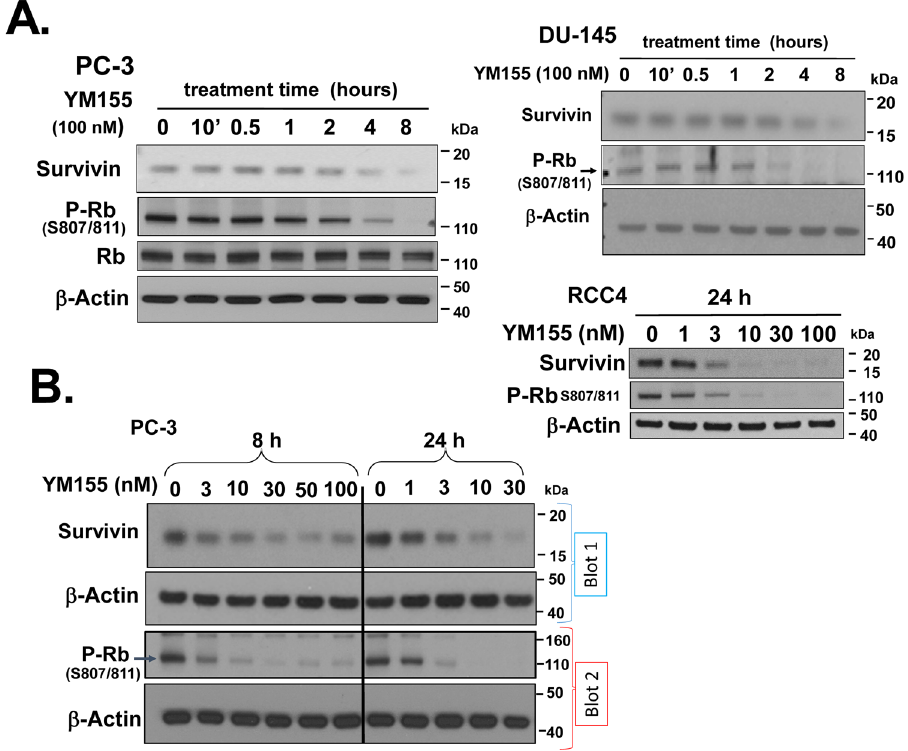
Figure 1. YM155 decreases Survivin expression and activates Rb in prostate and kidney cancer cells. ( A ) PC-3 and DU-145 cells were treated with 100 nM YM155 for various times (10 min – 8 h) as indicated, and expression of Survivin, Rb and p-Rb ser807/811 were assessed by Western blot. ( B ) PC-3 cells and RCC4 cells were treated with different concentrations of YM155 for 8 and 24 h, and the expression of Survivin and p-Rb ser807/811 were assessed by Western blot. Equal loading and transfer were confirmed by re-probing blots for β -Actin. Unless indicated on the figure, each group of blots represents data obtained from a single gel and experiment. Results shown are representative of 2–3 independent